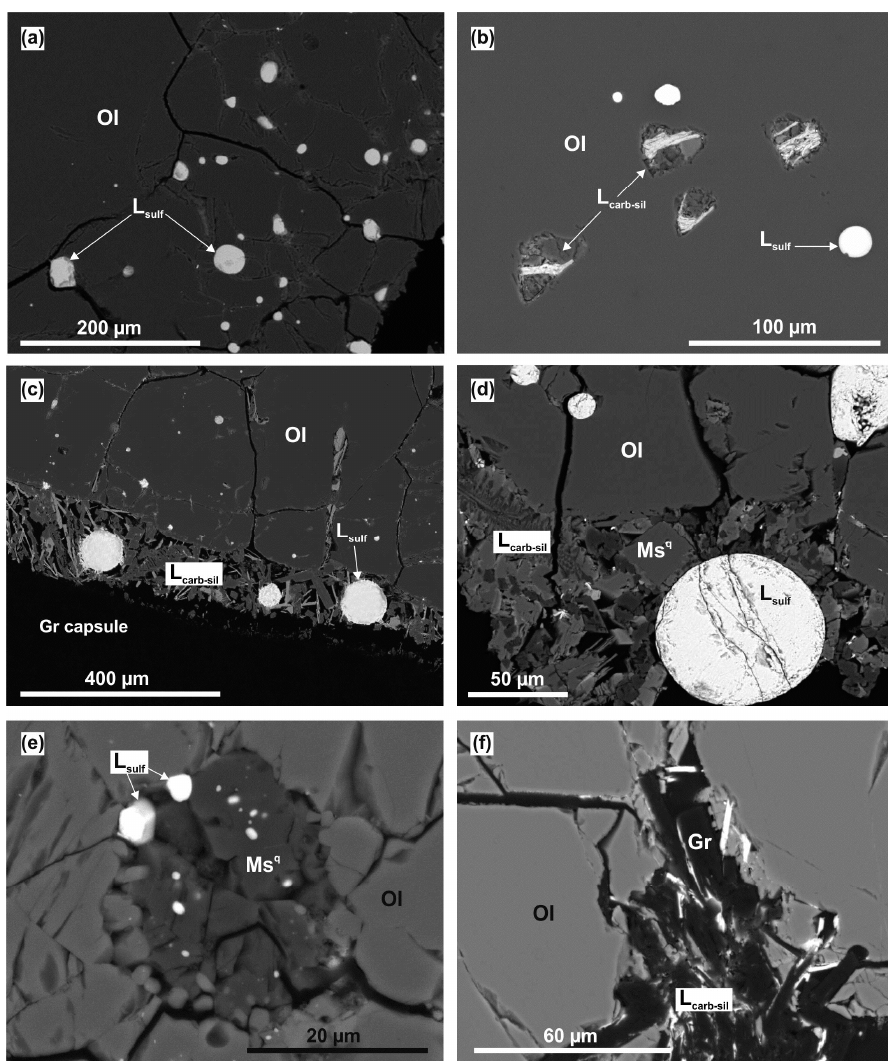
Figure 7. Scanning electron microscopy (SEM) images of polished fragments of the samples after experiments on the Mg-sulfate-olivine system, 1450 °C, xS = 5 mol %: ( a ) Polycrystalline aggregate of recrystallized olivine with sulfide and silicate-oxide melt in interstitions and inclusions; ( b ) inclusions of quenched sulfide and silicate-oxide melt in recrystallized olivine; ( c , d ) recrystallized olivine with inclusions, at the contact with the quenched silicate-oxide and sulfide immiscible melts; ( e ) aggregate of quenched ferromagnesite and sulfide melt; ( f ) recrystallized graphite in a quenched carbonate-silicate melt; Ol —olivine, L carb-sil —carbonate-silicate melt, L sulf —sulfide melt, Ms —magnesite, Gr —graphite, q —quenched phase.